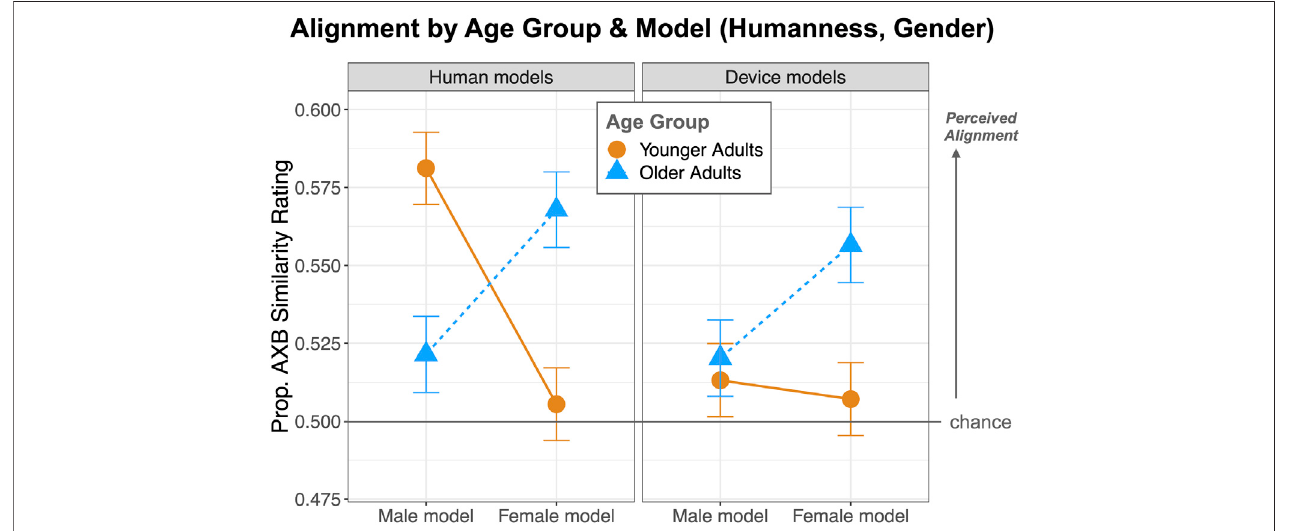
FIGURE3| MeanproportionandstandarderrorsofAXBperceptualsimilarityratingsforeachModelTalker,byHumanness(Devicevs.Human)andGender (F,M).